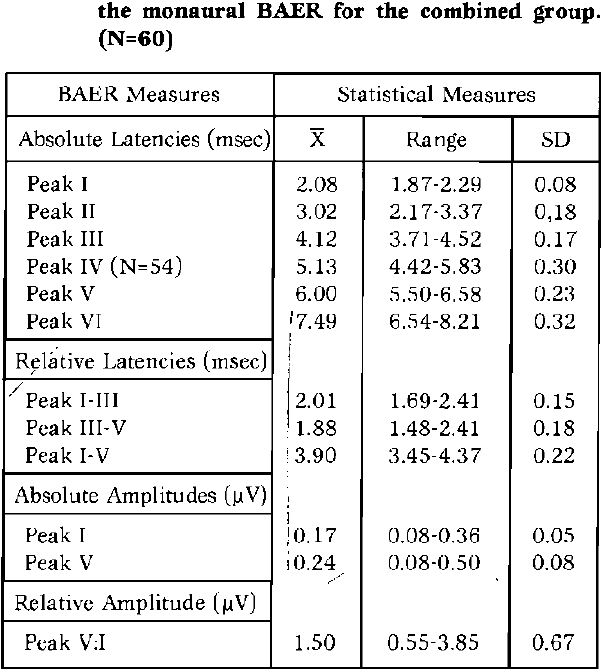
Table 2: Summary statistics for absolute and relative latencies in milli-seconds and absolute and rela- tive amplitude measurements in micro-volts of the monaural BAER for the combined